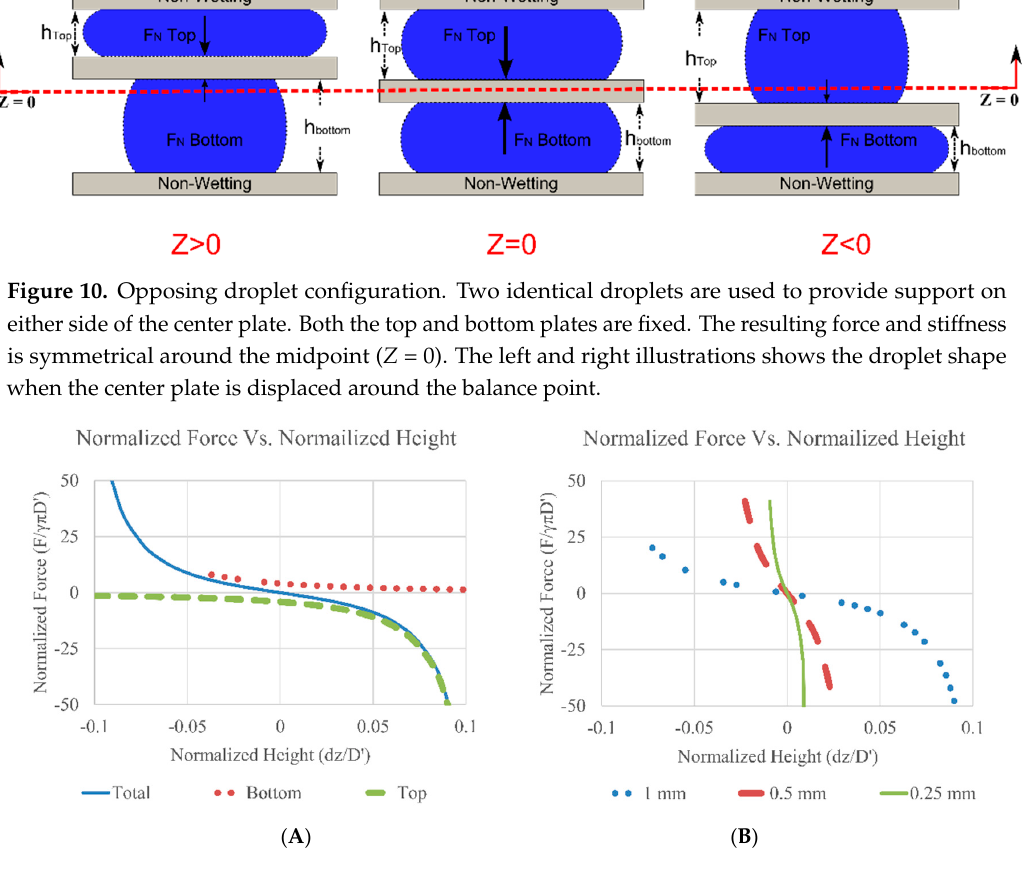
Figure 11. Opposing droplet configuration for optimal stiffness and precise z-location. ( A ) the normalized force from both the top and the bottom droplets are plotted against the normalized height (change in height divided by the nominal droplet diameter, dh / D’ ), the equilibrium height is 1 mm for both top and bottom gap. ( B ) Fixed gap heights with changing diameters. The contact angle used in calculation was 165° and the surface tension value used was 0.072 N/m.